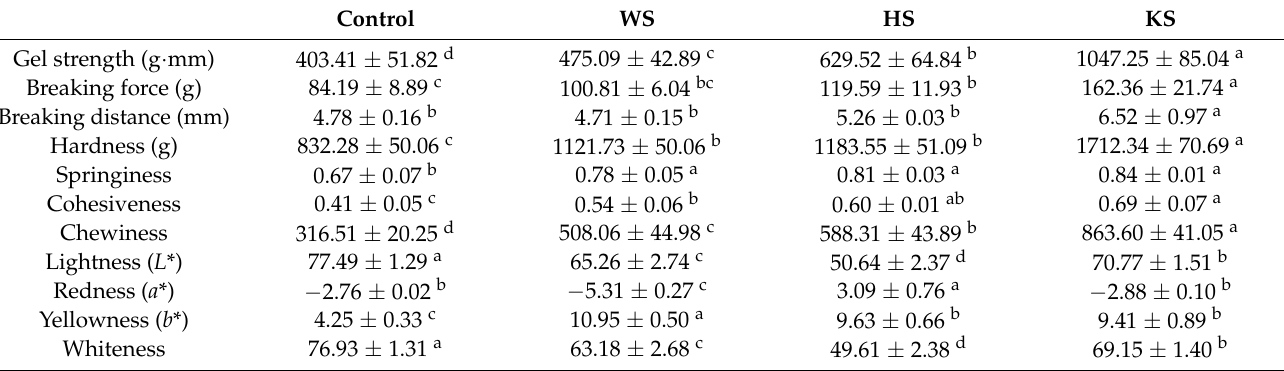
Table 1. Color and texture of silver carp surimi gel with different